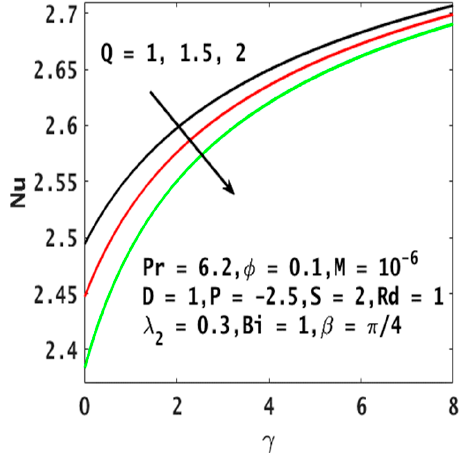
Figure 8. Variation of Nu with Q.